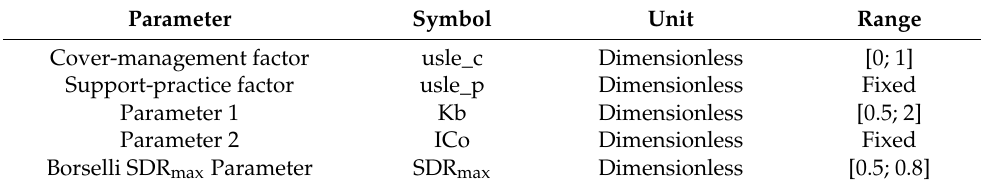
Table 9. Sediment Delivery Ratio model parameters.